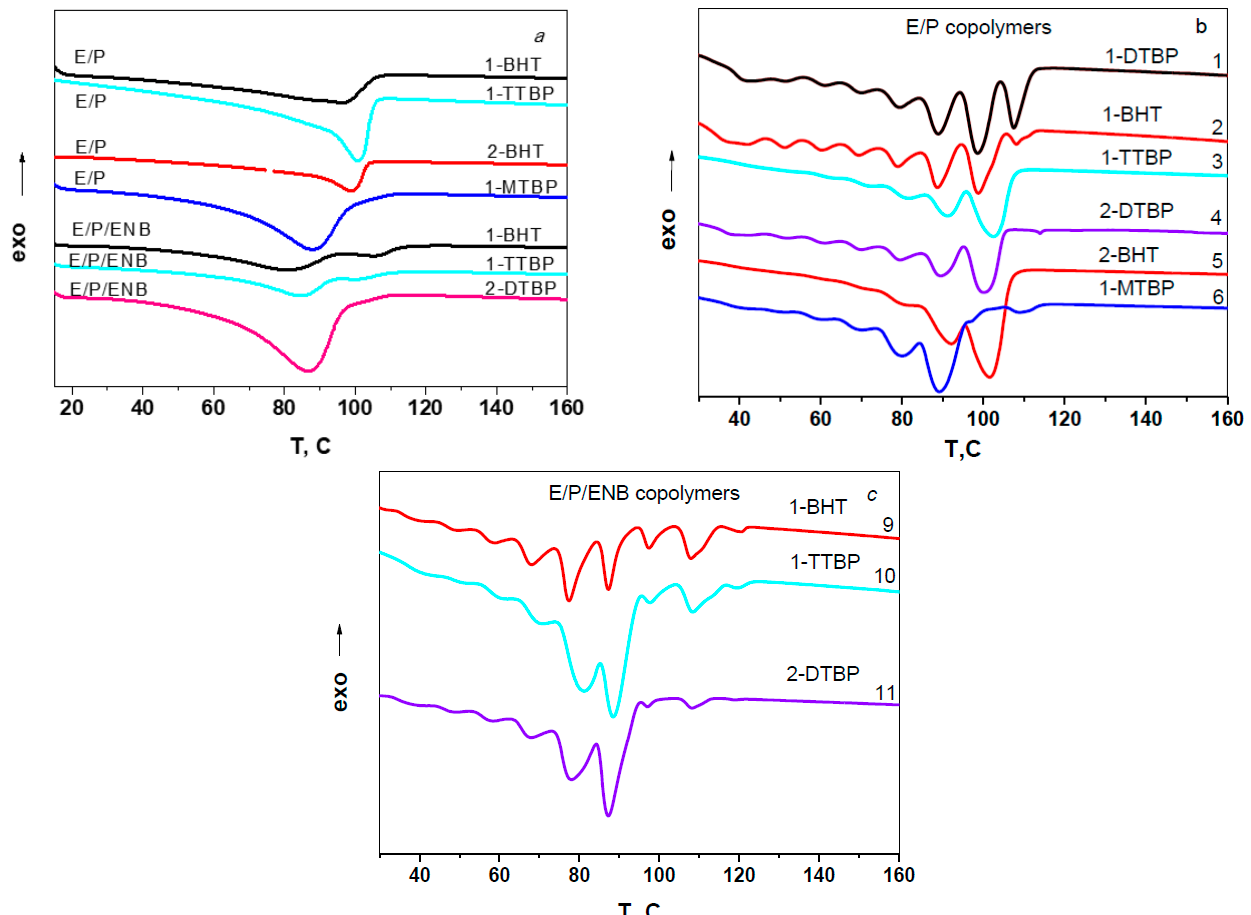
Figure 3. DSC thermograms for second cycle heating of pristine ( а ) and fractionated ( b , с ) E/P and E/P/ENB copolymers obtained on the rac -Et(2-MeInd) 2 ZrMe 2 /isobuthylaluminum aryloxide catalyst systems.